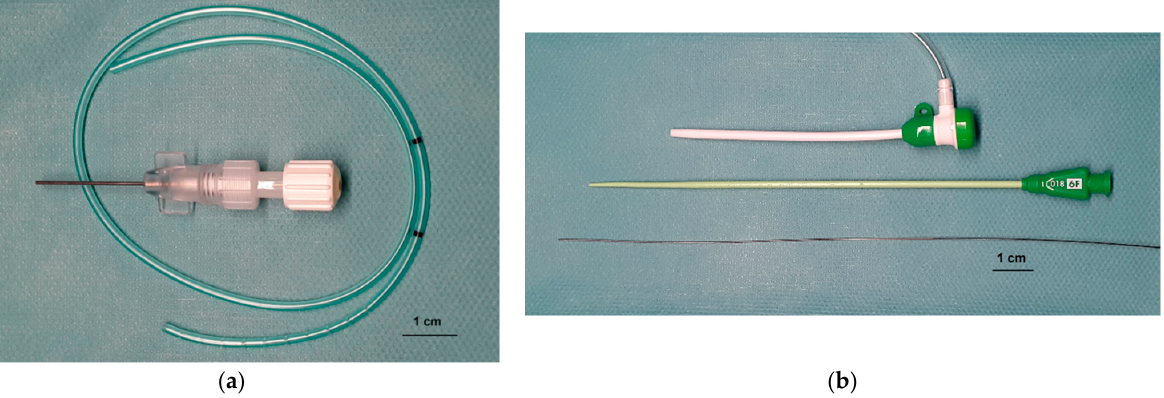
Figure 1. ( a ) and ( b ): Sheath-guided thoracostomy tube system consisting of a small-bore tube and a vascular sheath. ( a ): A 50 cm long 6 F tube with 20 fenestrations at a length of 5 cm. The wall thickness is 0.5 mm and the internal lumen diameter 1 mm. The distance to the fenestration is marked with two black markers at 2 cm and 4 cm distance. A Luer lock adapter is included. ( b ) A 6 F valved vascular sheath with its dilator and a 0.018-inch guidewire.